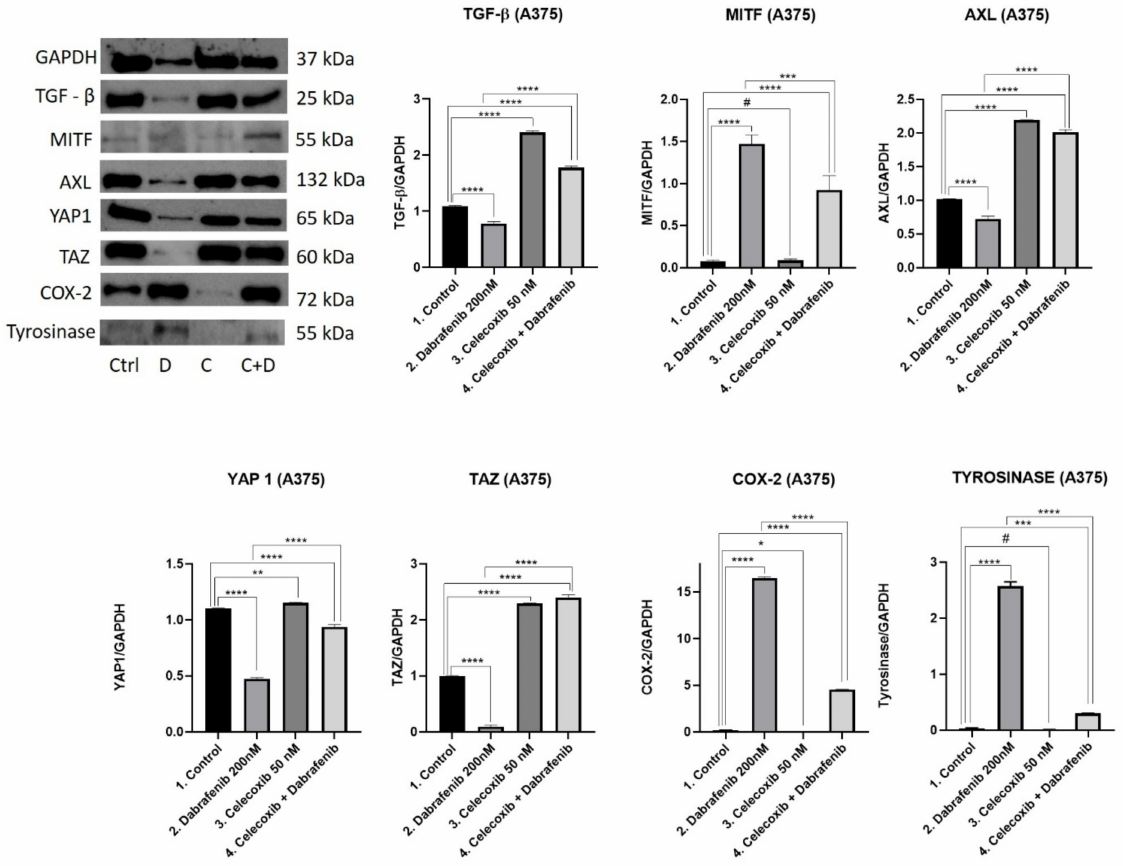
Figure 6. Western blot analysis for A375. Results were analyzed using GraphPad Software, Ordinary One-way ANOVA test, Multiple comparisons. Each bar represents mean ± standard deviation, n = 3. # = p > 0.05 (not significant), * = p < 0.05, ** = p < 0.01, *** = p < 0.001, **** = p < 0.0001. TGF- β . TGF- β release controls extracellular matrix stiffness (ECM), and promotes EDNRA receptor activation and nuclear YAP1 expression with further